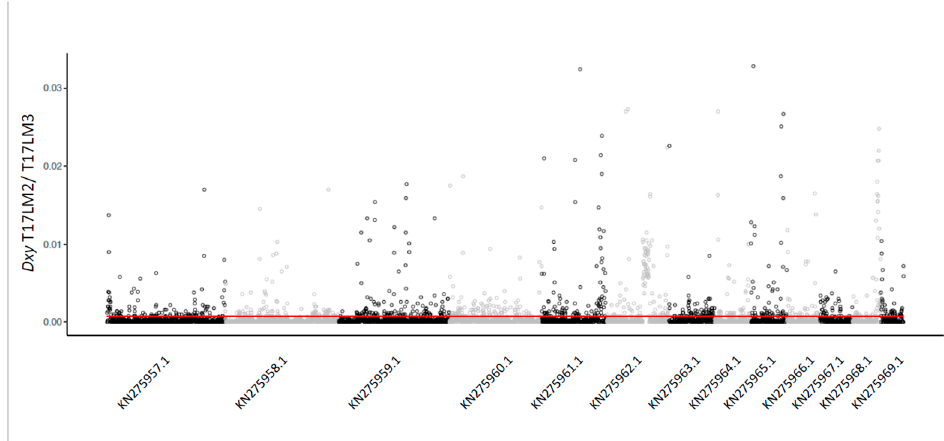
Figure 2. Whole-genome genetic distances between the isolates T17LM2 and T17LM3. Absolute genetic distance (dXY) between the isolates T17LM2 and T17LM3 were calculated by using 5 kb sliding window blocks and plotted across 13 largest scaffolds of the P. brasiliensis Pb18 reference